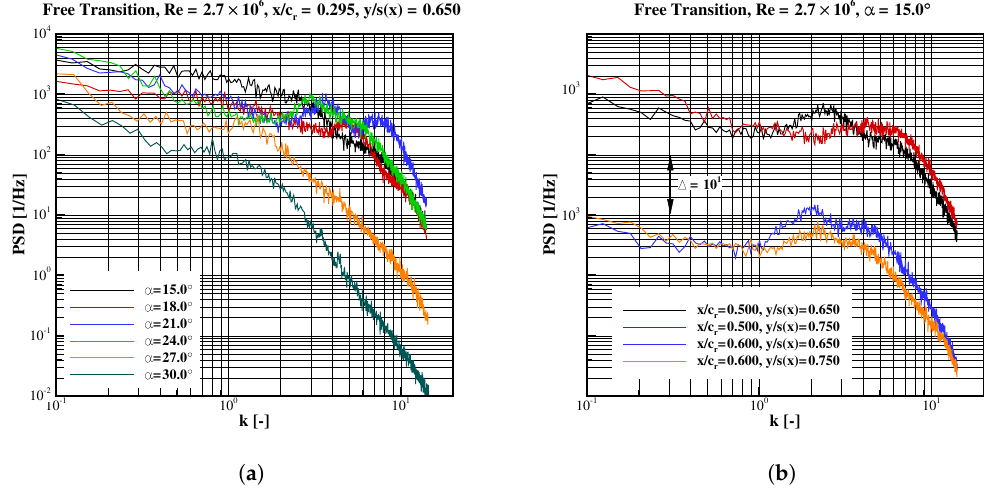
Figure 15. Power spectral density ( PSD ) of the pressure fluctuations c (cid:48) p as function of reduced frequency 10 6 . ( a ) Angle of attack variation; ( b ) Position variation at α = 15 ◦ k , at Re = 2.7 ×